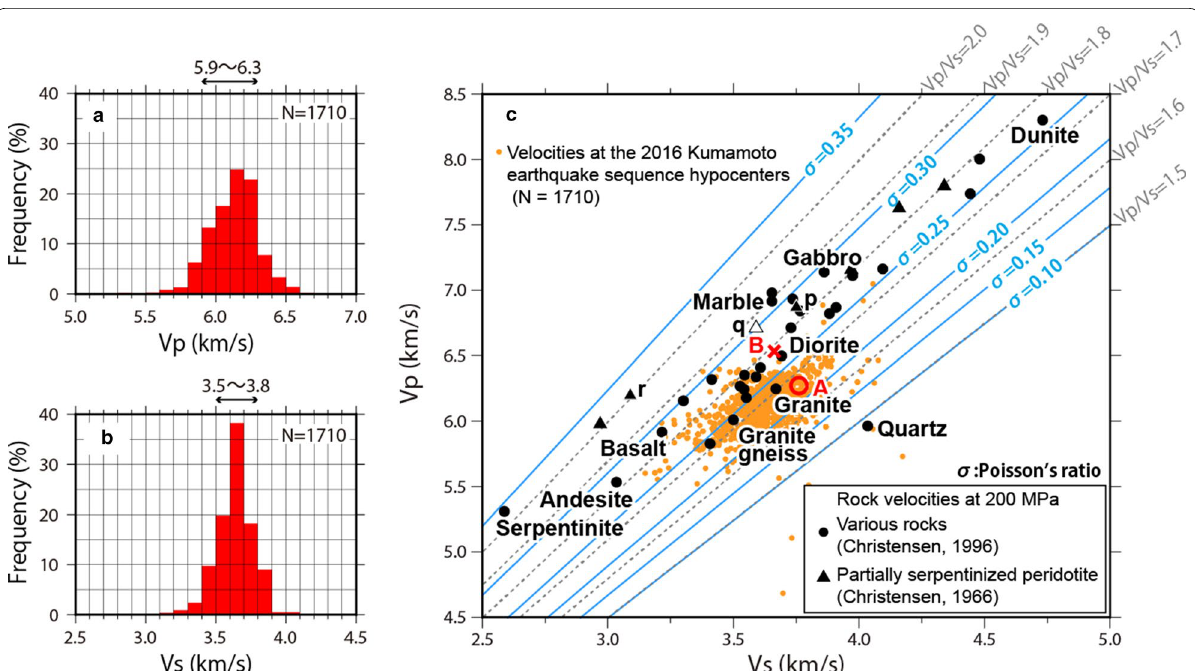
Fig. 8 Velocity distribution in the seismogenic zone and their relation to various rock types. a V p and b V s histograms obtained at each hypocenter in the final velocity model. c V p– V s relationship for the 2016 Kumamoto Earthquake sequence and corresponding rock types in a typical seismogenic zone. The black circles show the velocity distribution for various rock types at 200 MPa (Christensen 1996). The black triangles show the velocity distribution for partially serpentinized peridotite (Christensen 1966); ’p’ and ’r’ represent serpentinized volumes of 29.4 and 52.7%, respectively. The white triangle ’q’ represents the estimated velocities for 35% serpentinization. Points A and B represent the velocities at the rupture propagation and rupture termination points, respectively; these points are shown in Fig. 7 and referred to in Table